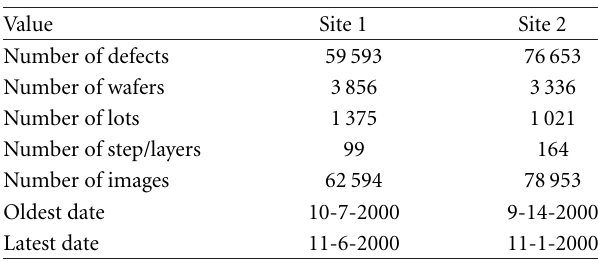
Table 2: Database statistics for Sites 1 and